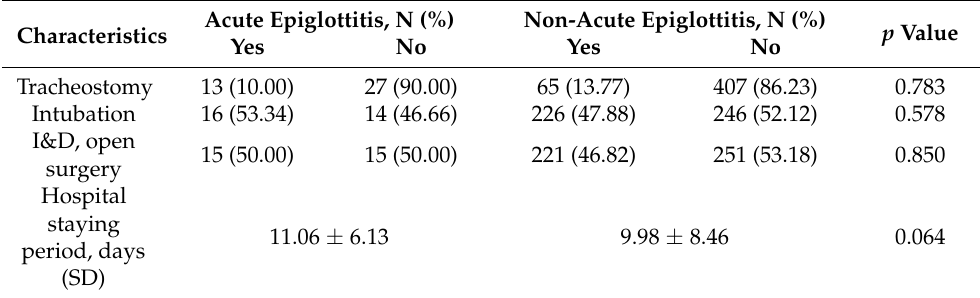
Table 4. Comparison of managements and hospital staying period between 30 patients with concur- rent acute epiglottitis and deep neck infection and 472 patients with deep neck infection alone.